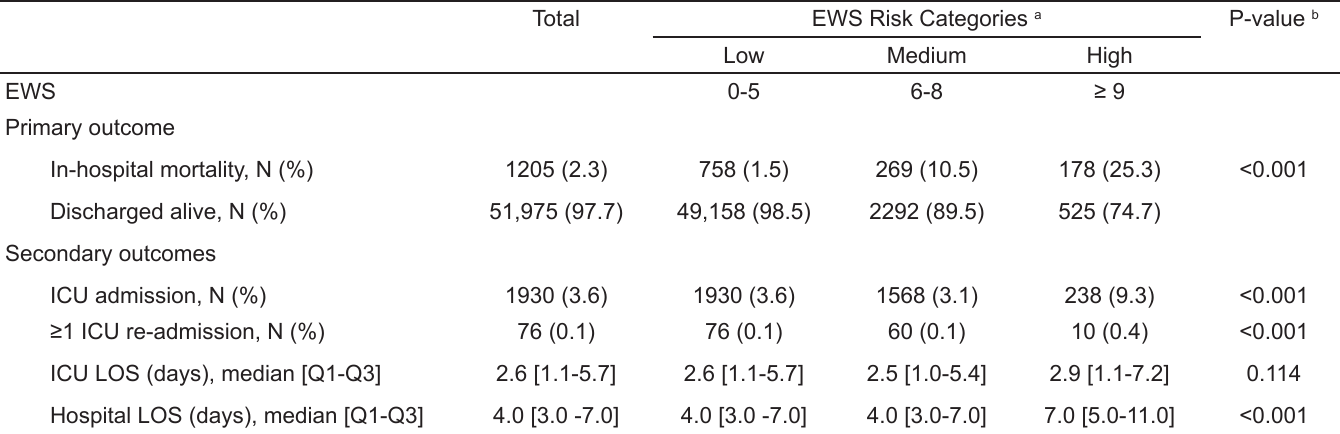
Table 2. Outcomes for the Early Warning Score (EWS) risk categories based on the initial EWS.